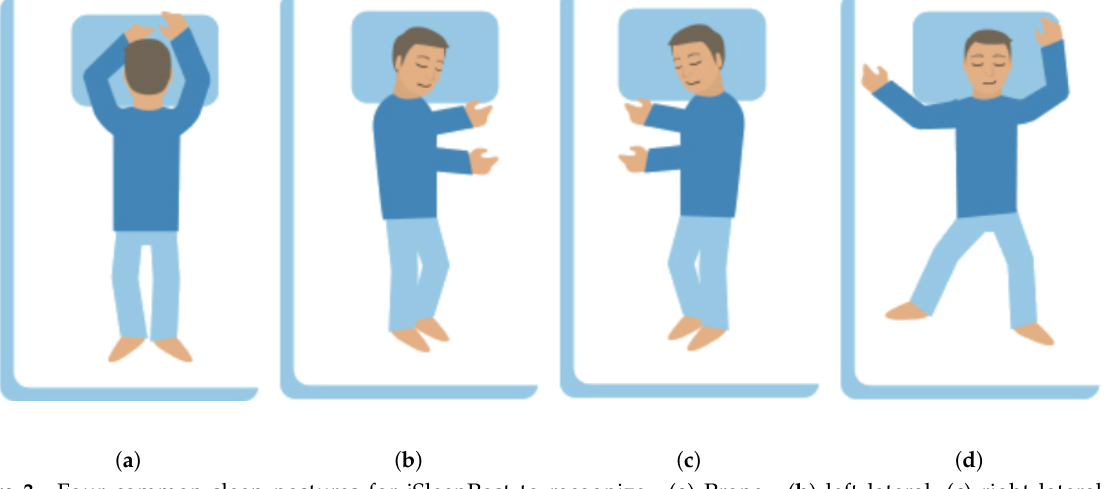
Figure 3. Four common sleep postures for iSleepPost to recognize. ( a ) Prone , ( b ) left lateral, ( c ) right lateral and ( d ) supine